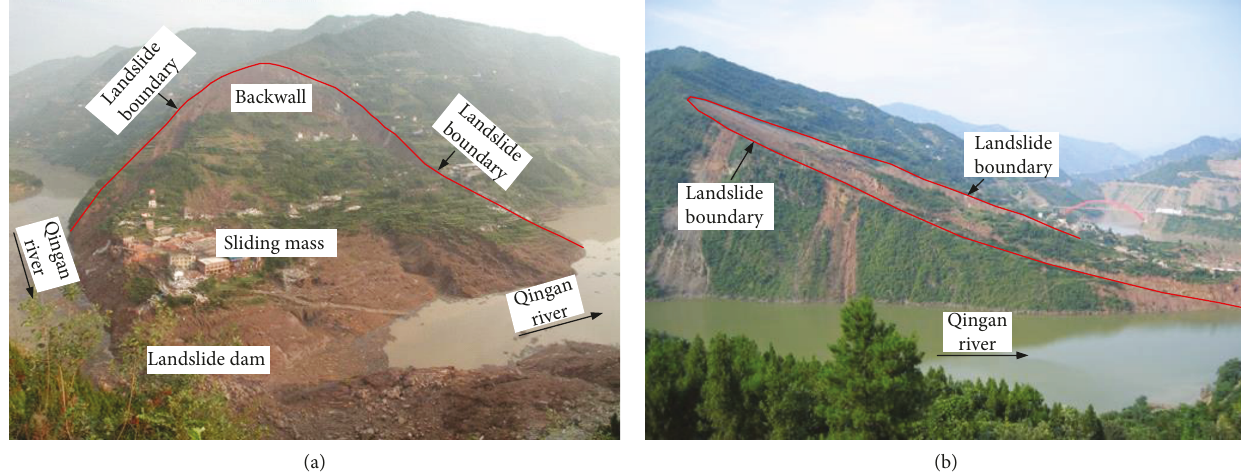
Figure 2: Photos of the Qianjiangping landslide [14]: (a) panorama of the landslide; (b) upstream side view of the landslide.